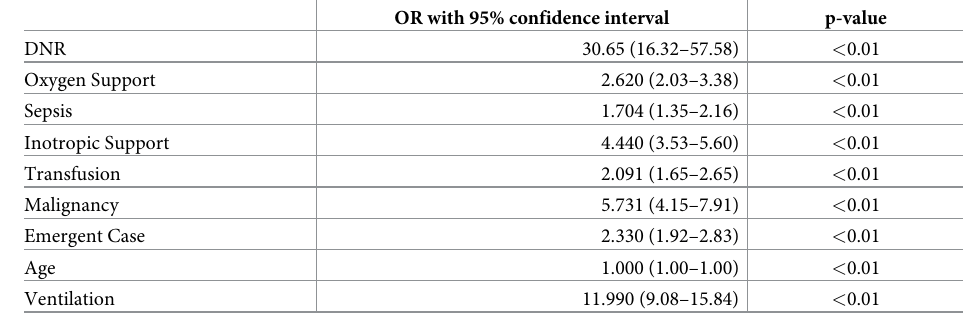
Table 5. Parsimonious LR model built on variables selected by classification tree